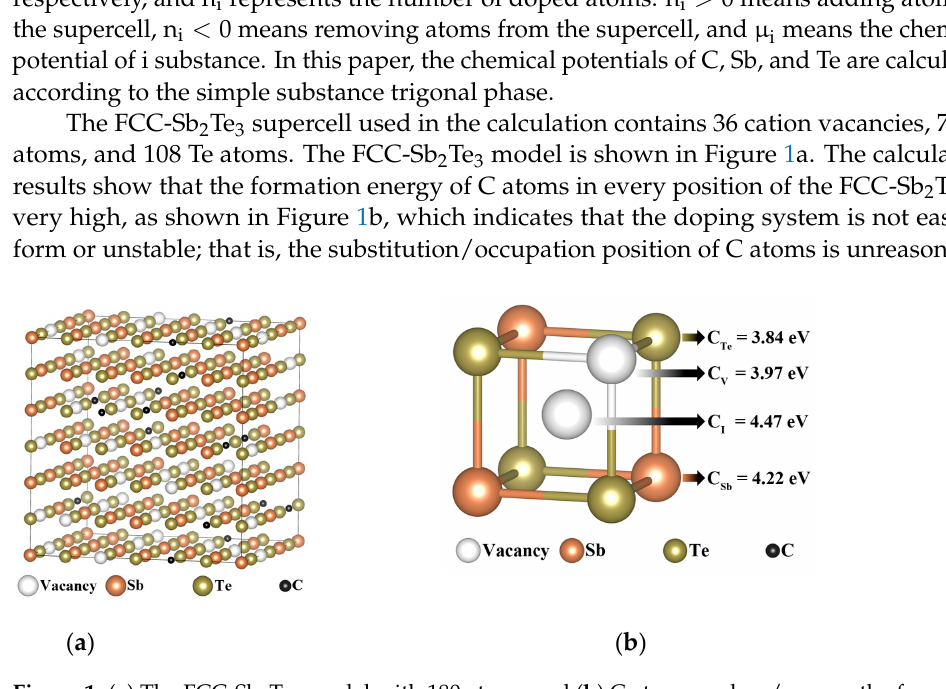
Figure 1. ( a ) The FCC-Sb 2 Te 3 model with 180 atoms and ( b ) C atoms replace/occupy the formation energies of Sb, Te atoms, Sb vacancies, and intervals in the FCC-Sb 2 Te 3 , respectively.